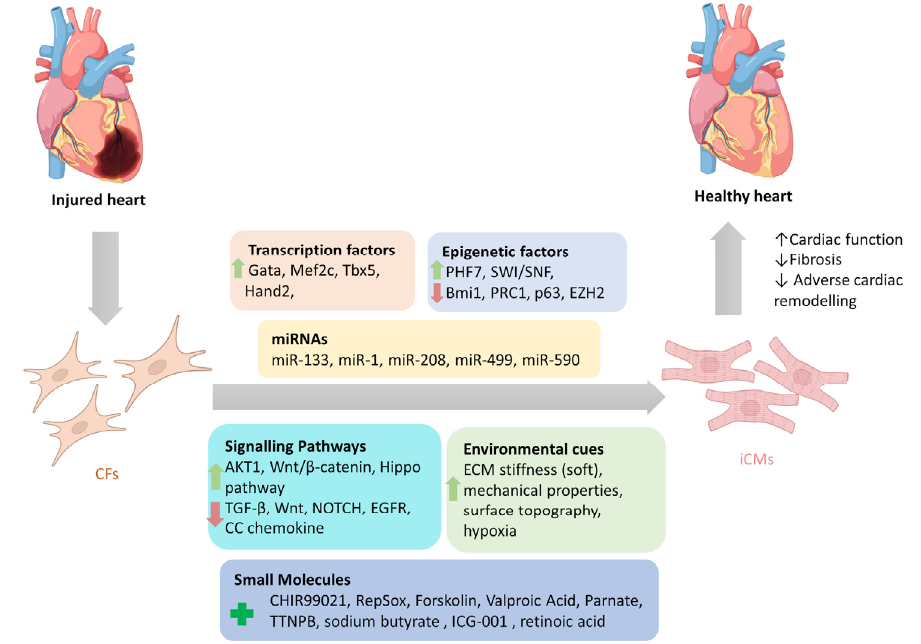
Figure 1. Reprogramming factors involved in direct cardiac reprogramming of cardiac fibroblasts into induced cardiomyocytes. Modulation of several reprogramming factors (separately or combined) that include transcription factors, epigenetic factors, miRNAs, signalling pathways, and environmental cues can directly reprogram cardiac fibroblasts into induced cardiomyocytes. (CFs: cardiac fibroblasts; iCMs: induced cardiomyocytes).